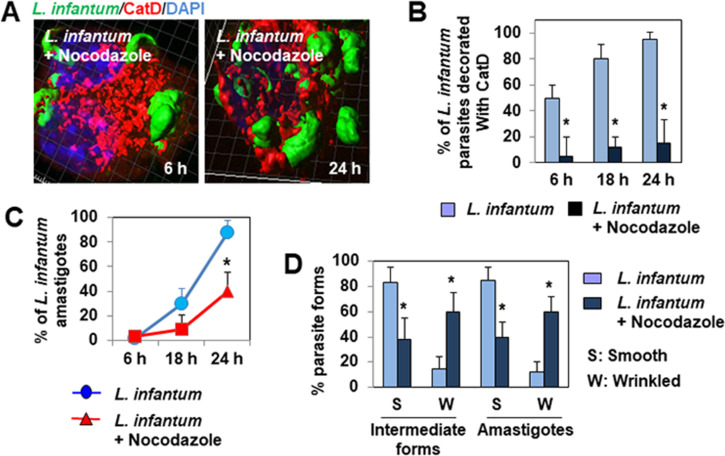
The microtubule-disassembly agent nocodazole abolishes the maturation of L. infantum LEM 5700-containing phagosomes, delays parasite differentiation, and promotes parasite death in macrophage-like Raw 264.7 cells.(A) 3D-reconstruction surface rendering confocal micrographs showing limited association of cathepsin D (CatD) with parasites hosted in nocodazole-treated infected cells. For comparison, see the CatD decoration of parasites hosted in untreated cells in Fig 1G. (B) Bar graph showing the percentage of parasites decorated with CatD in cells infected in the continuous presence, or not, of nocodazole during a time-course of infection. (C) Graph showing the time-dependent evolution of the percentage of amastigotes in cells infected in the continuous presence, or not, of nocodazole (1 μM) during a time-course of infection. (D) Bar graph showing the percentage of intermediate parasite forms and amastigotes exhibiting a smooth or wrinkled body surface when hosted in cells infected in the continuous presence, or not, of nocodazole. Confocal micrographs are representative of two independent experiments. The percentage of parasites was determined by analyzing at least 30 cells for each time-point for each condition. Data are presented as averages ± SEM and were analyzed using the unpaired Student t test. *p < 0.01.